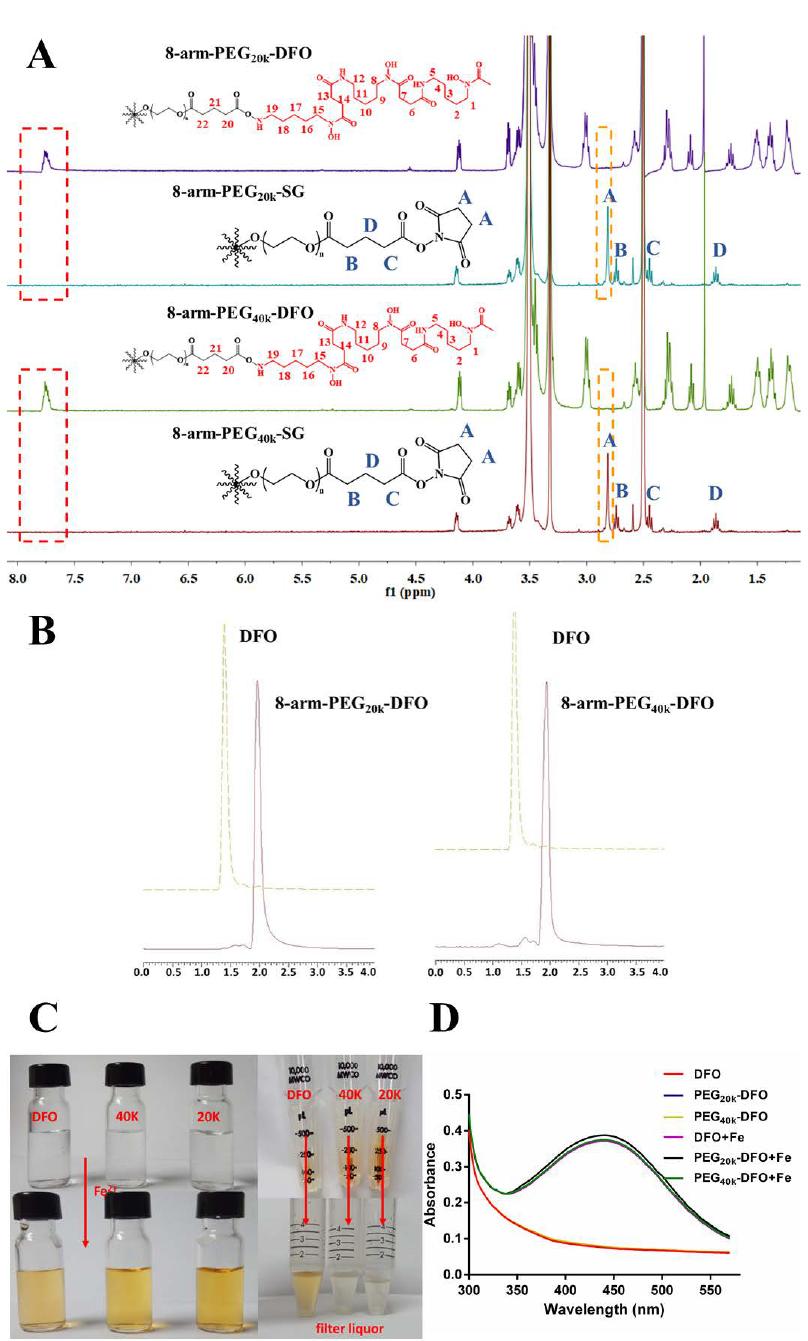
Figure 2. The synthesis and characterization of 8-arm-PEG-DFO conjugates. ( A ) The 1 H NMR spectrums of the products and the materials. Both of the newly-appeared conjugates peak at 7.75 ppm, which is attributed to the amido bonds and the disappearance of the methylene characteristic peaks at 2.80 ppm on succinimide (peak A), as indicated by the synthesis of the 8-arm-PEG-DFO conjugates. Characteristic peaks of 8-arm-PEG-DFO: (3.4 ppm: H-5, H-12, and H-19; 3.0 ppm: H-1, H-8 and H-15; 2.6 ppm: H-6, H-13; 2.3 ppm: H-7, H-14, H-22; 2.1 ppm: H-20; 1.9 ppm: -CH 3 ; 1.7 ppm: H-21; 1.5 ppm: H-4, H-11, and H-18; 1.4 ppm: H-2, H-9, H-16; 1.2 ppm: H-3, H-10, and H-17); ( B ) The HPLC chromatograms for the free DFO and the 8-arm-PEG-DFO conjugates; ( C ) The optical images of DFO, 8-arm-PEG 20k -DFO, and 8-arm-PEG 40k -DFO solutions, and the ultrafiltration centrifugation of the DFO-Fe 2 + and 8-arm-PEG-DFO conjugates-Fe 2 + chelates; ( D ) UV-visible spectra of aqueous solution of DFO, 8-arm-PEG 20k -DFO, and 8-arm-PEG 40k -DFO with Fe (II). Spectra of 8-arm-PEG-DFO conjugates and DFO without Fe (II) were also